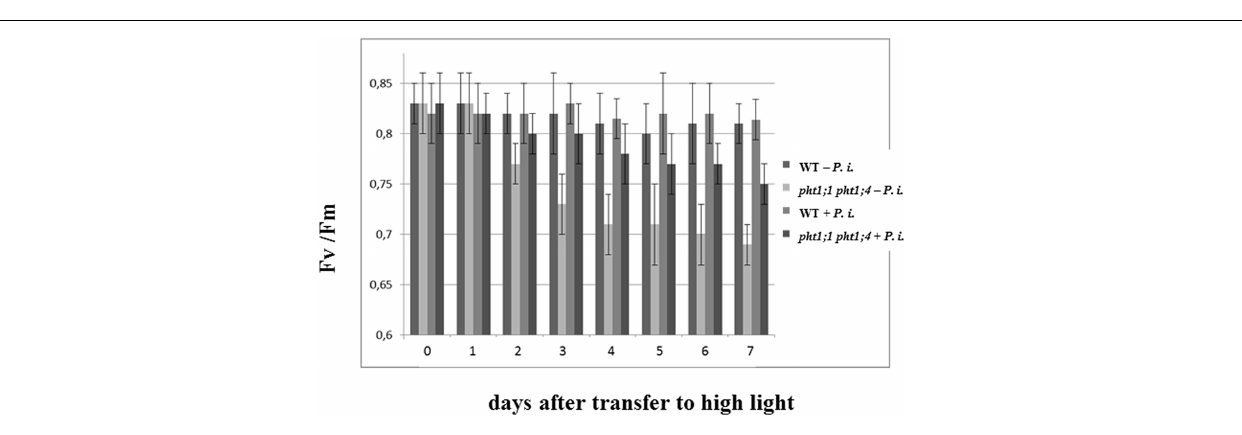
Frontiers in Microbiology |